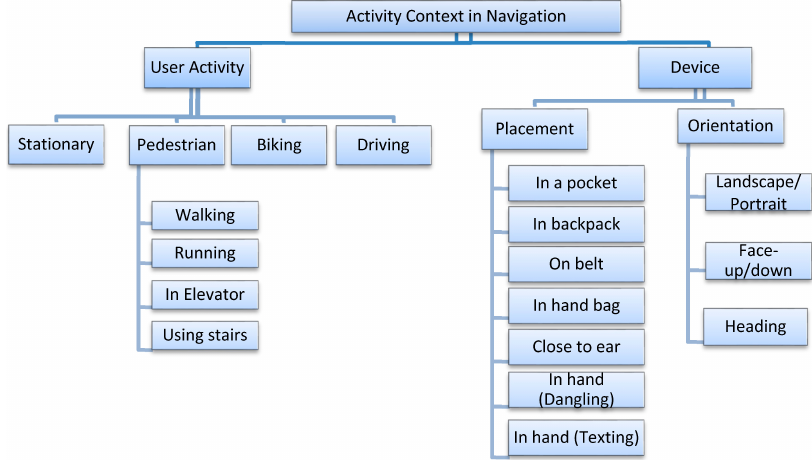
Figure 6. Different activity contexts assumed for personal navigation services.